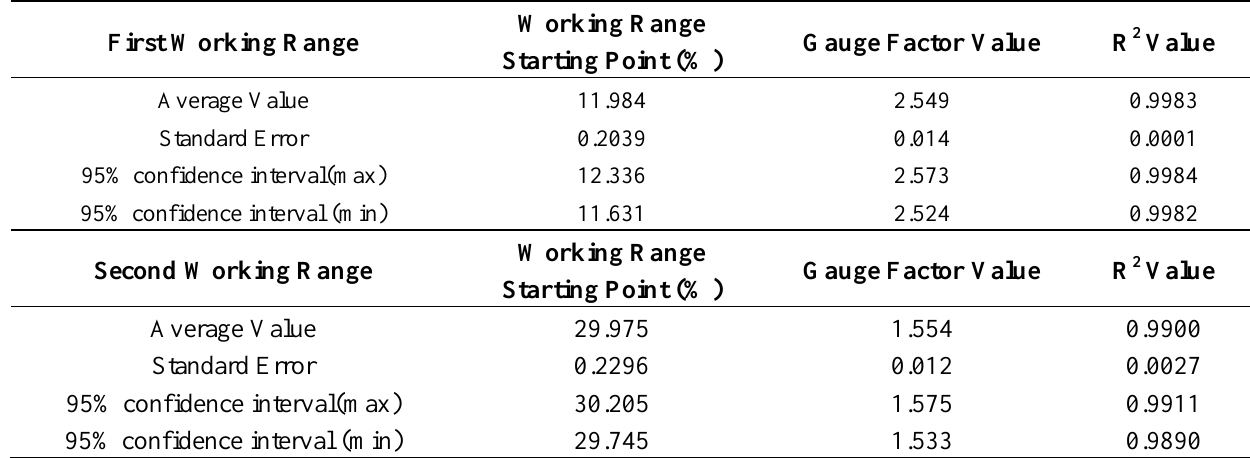
Table 7. Statistical results of samples with conductive yarn of 5 cN input tension.